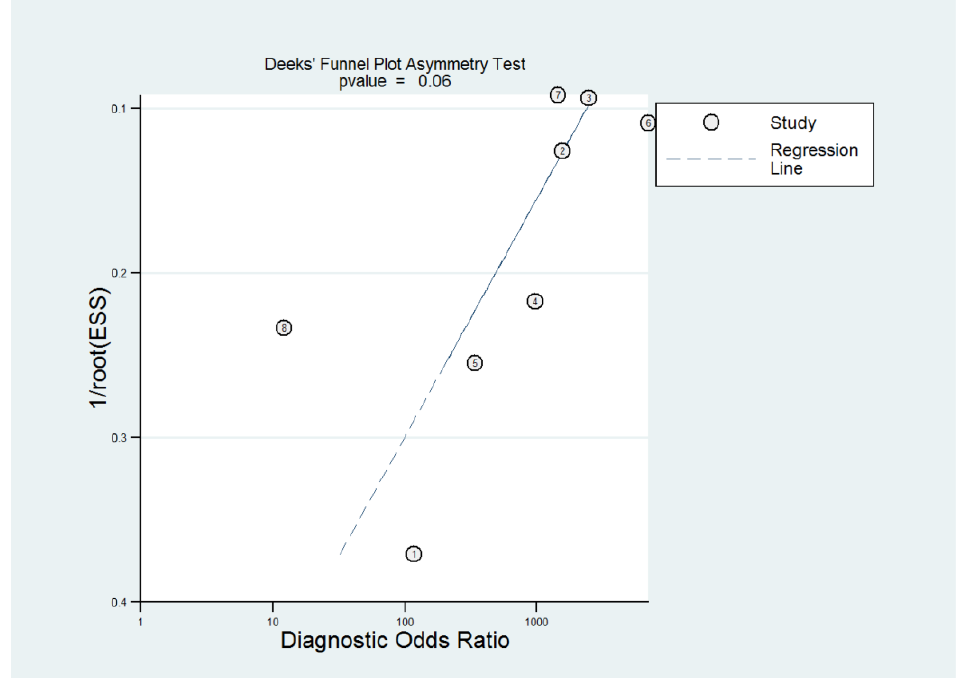
Figure 9. Publication bias regarding two-dimensional transvaginal sonohysterography .